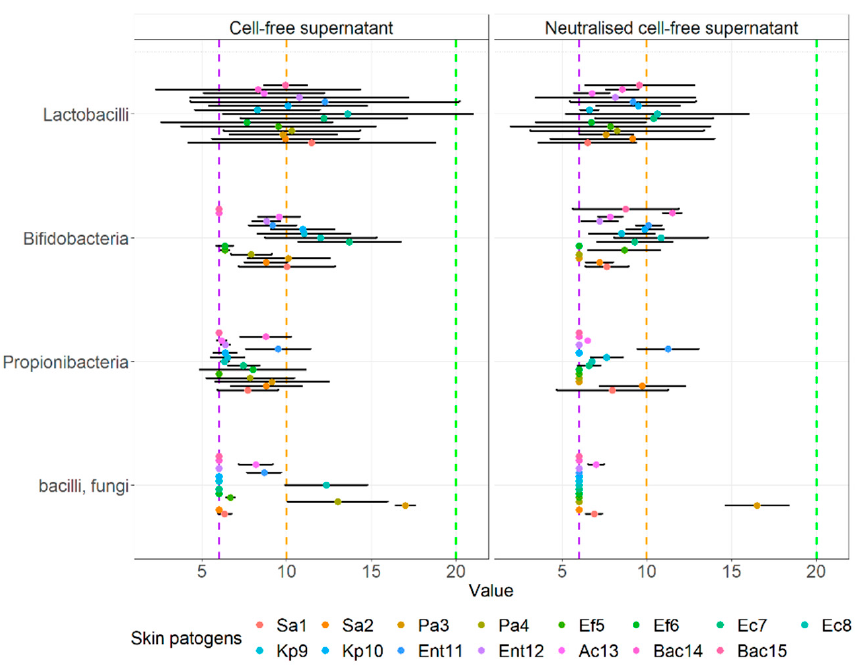
Figure 7. Means of inhibition zone together with 95% CI of cell-free supernatants of probiotics and other beneficial microbes, divided into groups according to main species, against clinical skin pathogens using the agar well diffusion assay.